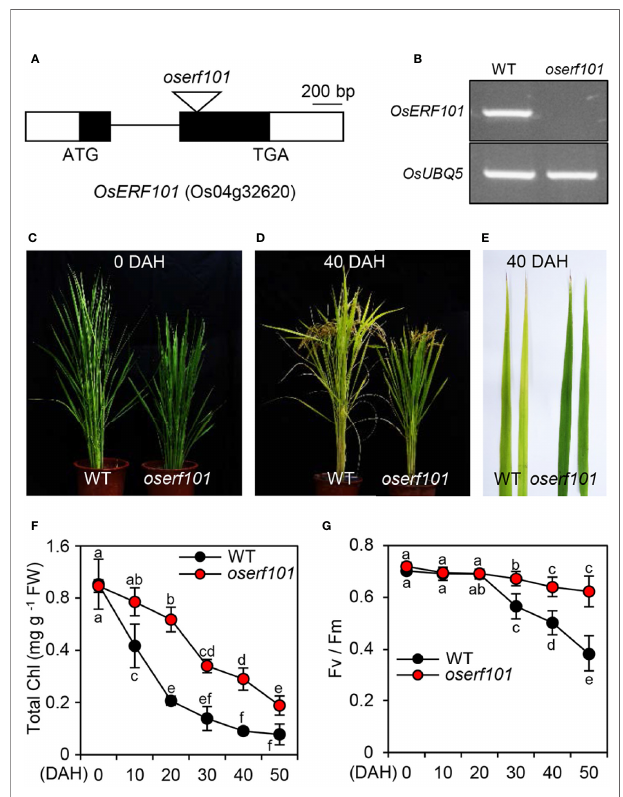
FIGURE 2 | The oserf101 mutant exhibits delayed natural leaf senescence. (A) Position of the T-DNA insertion in the exon region of OsERF101 (LOC_Os04g32620). Black and white boxes represent exons and untranslated regions, respectively. The black line indicates an intron and the open triangle indicates the location of the T-DNA insertion ( oserf101 , PFG_2D-00368). (B) Mutation of OsERF101 was con fi rmed by semi- quantitative RT-PCR. Total RNA was isolated from detached second leaves of a 3-week-old WT (the parental japonica rice cultivar ’ Dongjin ’ ) plant and the oserf101 mutant in which senescence was induced for 3 days of dark incubation as shown in Figure 3A. OsUBQ5 (Os01g22490) was used as a loading control. (C, D) The comparison of senescence phenotypes of WT and oserf101 plants at 0 and 40 days after heading (DAH) under natural long-day conditions (>14 h light/day). (E) Senescing fl ag leaves of WT and oserf101 plants at 50 DAH. The images are representative of fi ve independent experiments. (F, G) Changes in total chlorophyll (Chl) contents (F) and photosynthetic capacity (Fv/Fm) (G) of WT and oserf101 fl ag leaves after heading. Mean and standard deviations were obtained from more than 10 plants. Different letters indicate signi fi cantly different values according to a one-way ANOVA and Duncan ’ s least signi fi cant range test ( p <